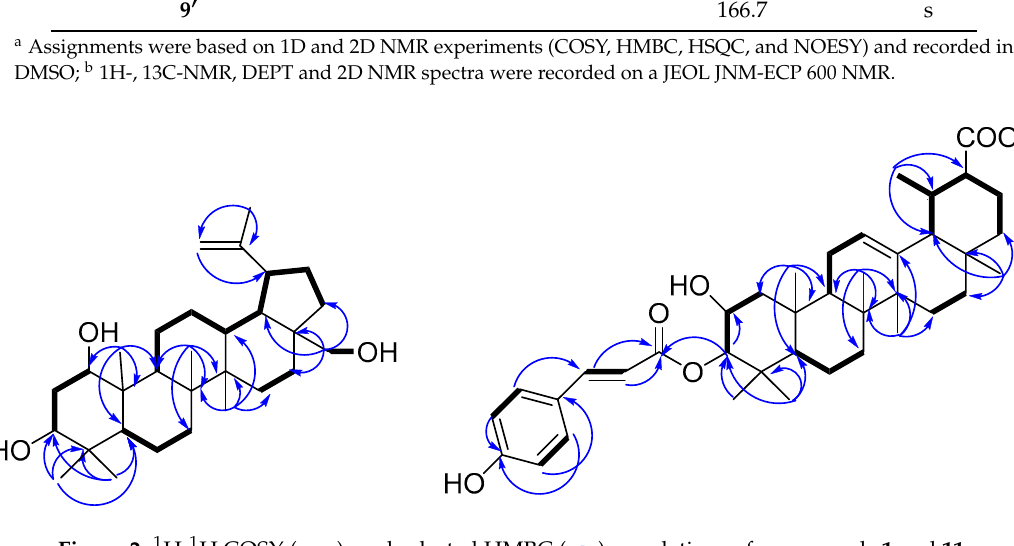
Figure 2. 1 H- 1 H COSY ( ), and selected HMBC ( ) correlations of compounds 1 and 11 .